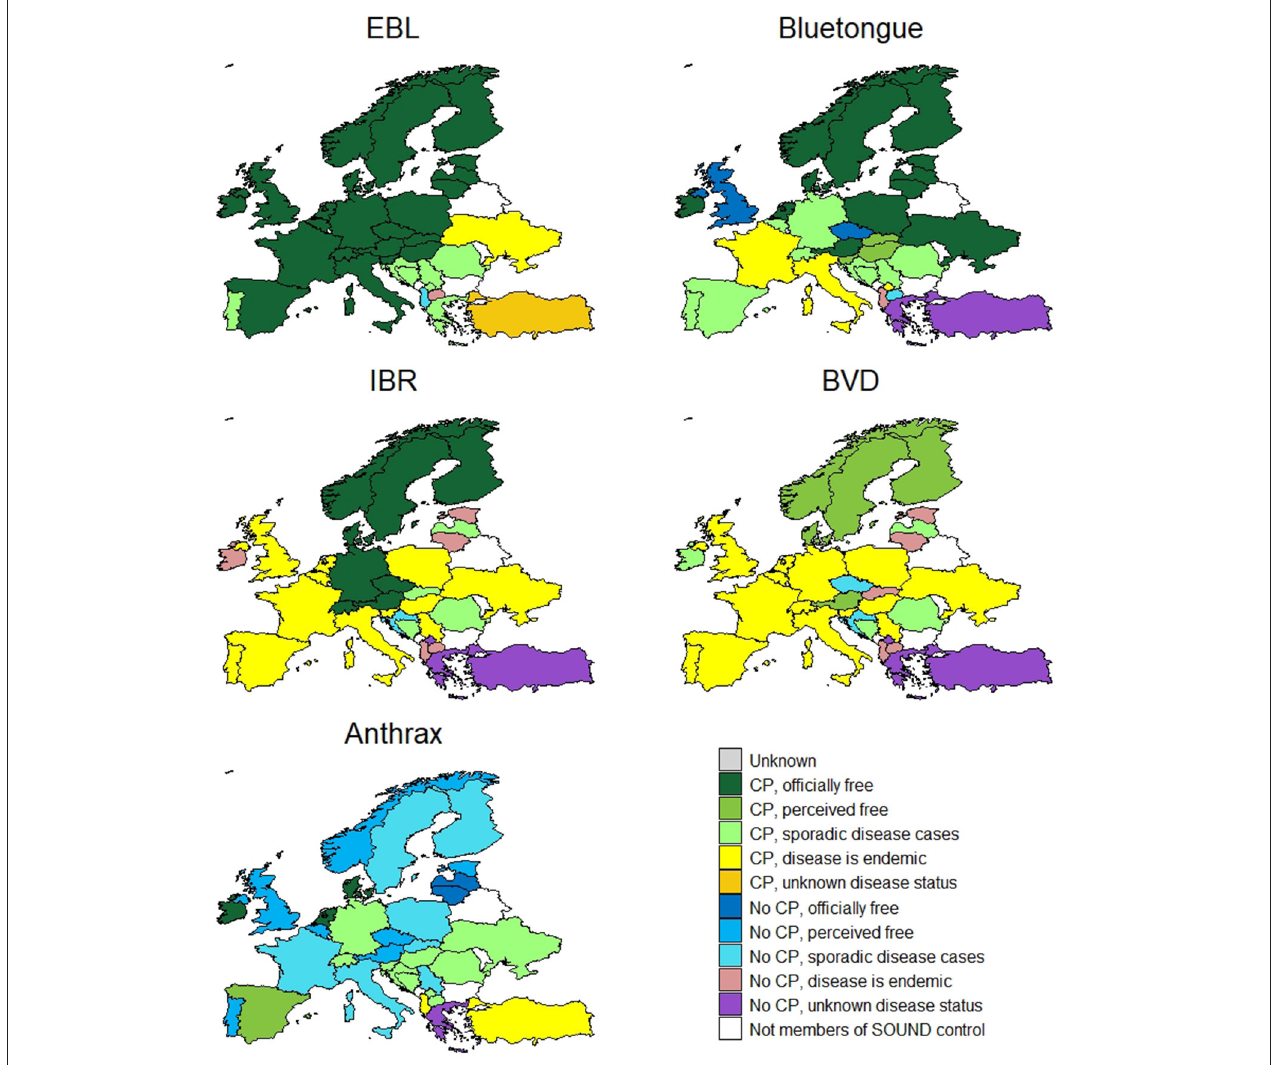
FIGURE 4 | Country level information on control programme implementation and disease status for enzootic bovine leukosis (EBL), bluetongue, infectious bovine rhinotracheitis (IBR), bovine viral diarrhoea (BVD) and anthrax.